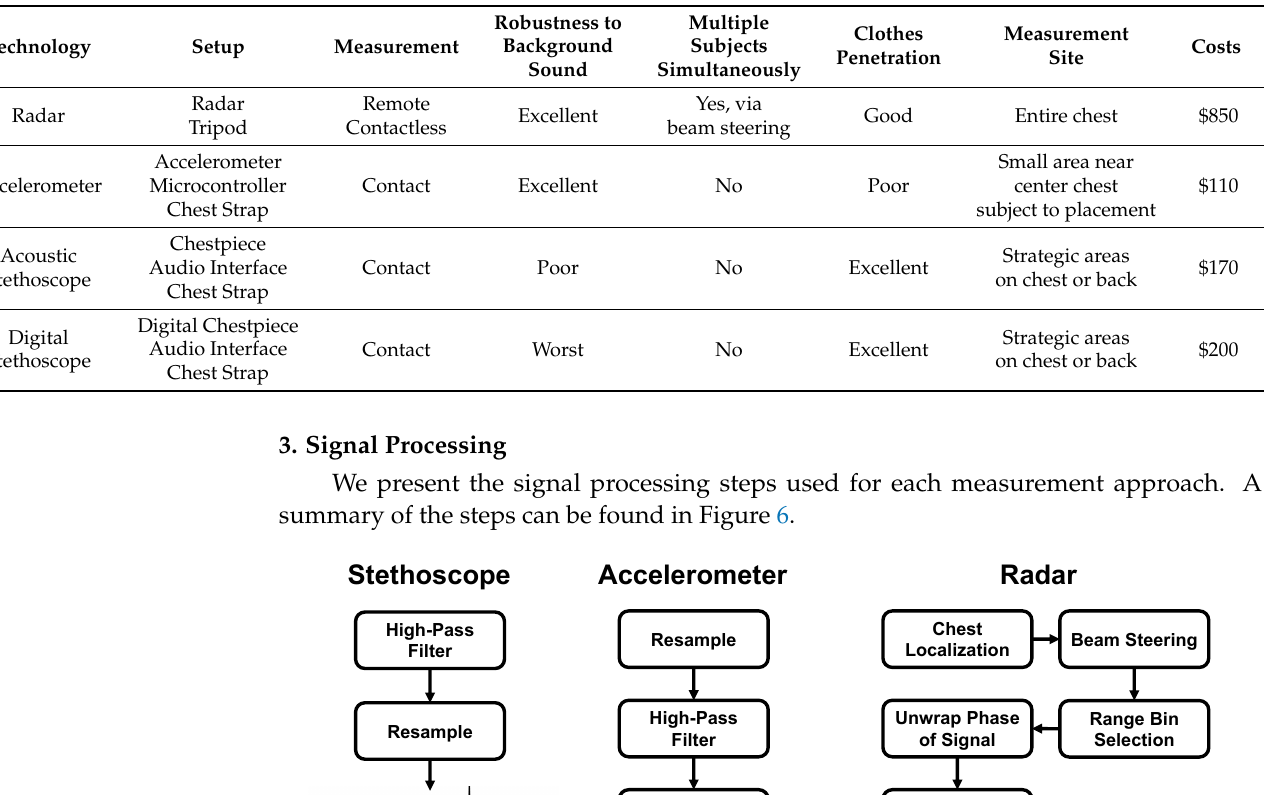
Table 1. The key features of each measurement system.